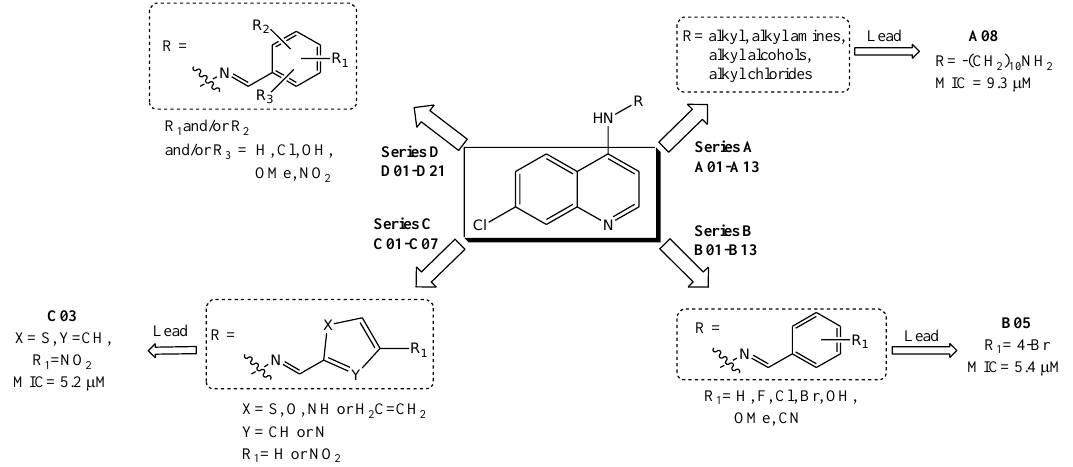
Figure 1. Series A – D of 7-chloro-4-aminoquinoline derivatives synthesized and evaluated against the Mycobacterium tuberculosis wild-type H37Rv strain (minimum inhibitory concentration, MIC) by our research group and their respective lead compounds.